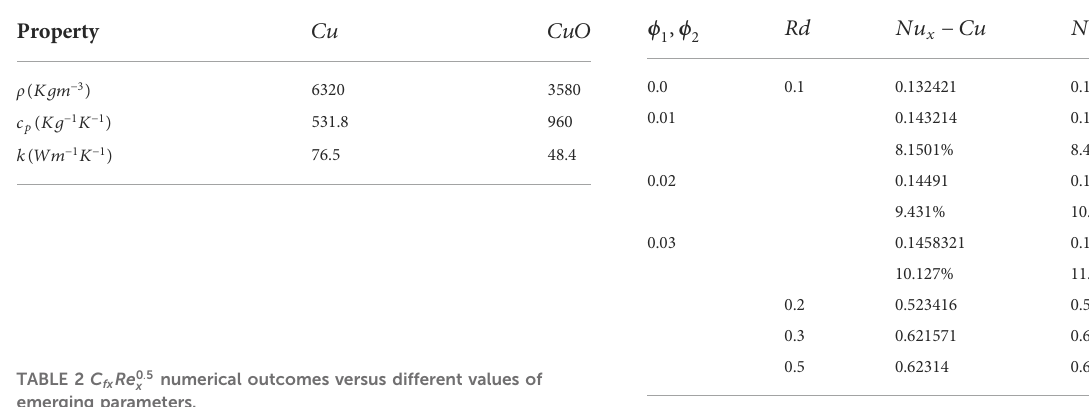
TABLE 1 Cu & CuO thermo-physical properties.